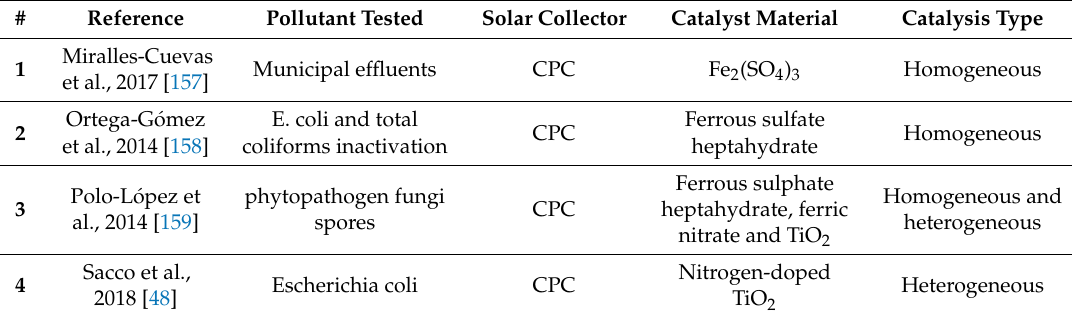
Table 12. SODIS real wastewaters (Bacteria and